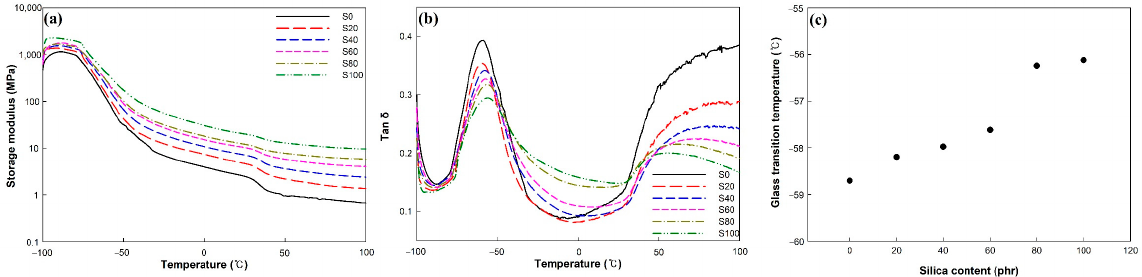
Figure 4. Dynamic mechanical analysis of the EPDM/silica vulcanizates: ( a ) storage modulus, ( b ) tan δ , and ( c ) glass transition temperature .